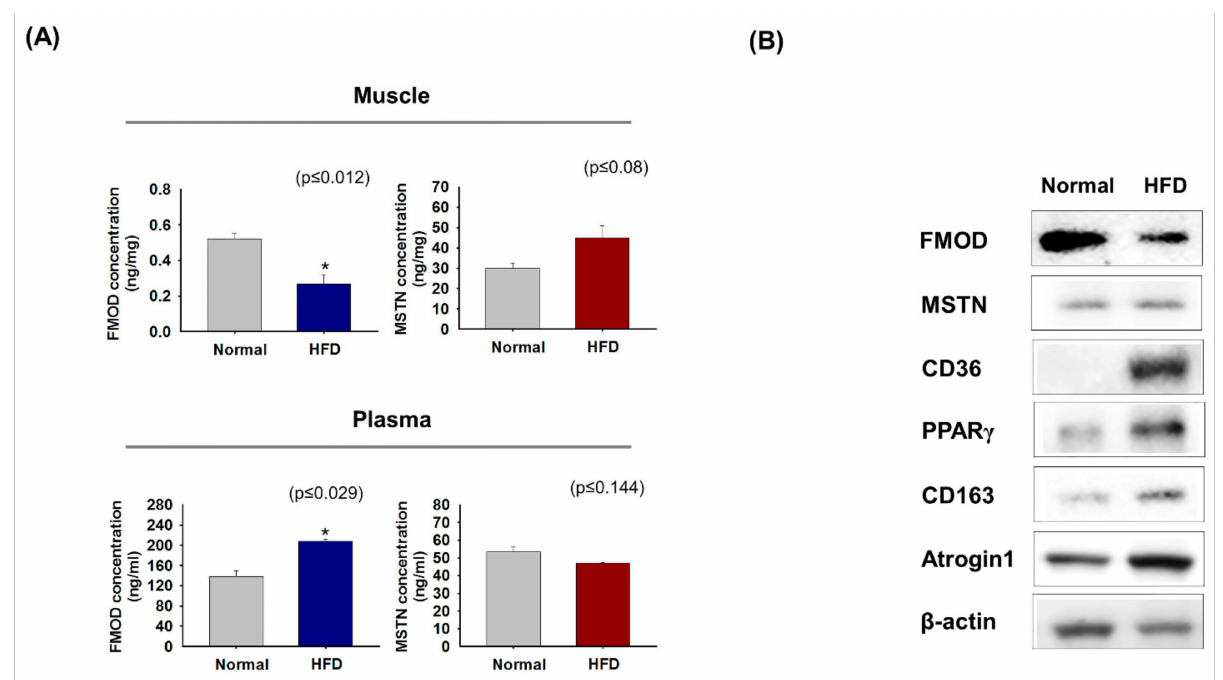
Figure 6. FMOD and MSTN protein levels in normal and HFD mouse muscles and plasma. ( A ) FMOD and MSTN protein concentrations were assessed by ELISA in normal and HFD mice gas muscles and plasma. ( B ) FMOD, MSTN, CD36, PPAR γ , CD163, and Atrogin1 protein levels were determined by Western blot. Normal indicates muscle and plasma of mice fed a normal diet. Means ± SD (n > 3). * p ≤